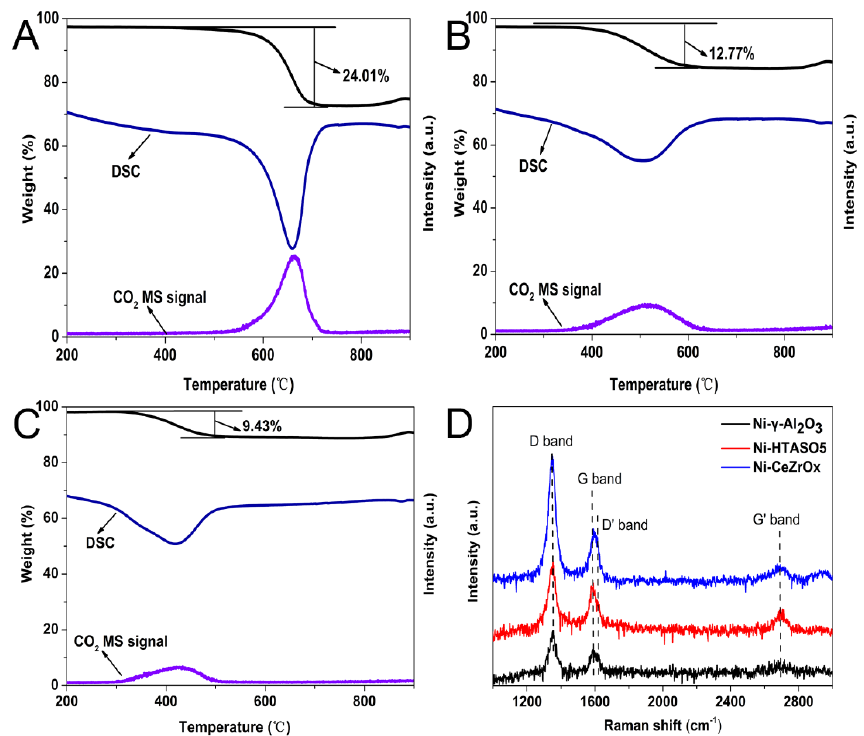
Figure 6. TG ‐ DSC ‐ MS profile. ( A ) Ni ‐γ‐ Al2O3; ( B ) Ni ‐ HTASO5; ( C ) Ni ‐ CeZrO x ; ( D ) Raman spectra of Figure 6. TG-DSC-MS profile. ( A ) Ni- γ -Al2O3; ( B ) Ni-HTASO5; ( C ) Ni-CeZrO x ; ( D ) Raman spectra of different Ni ‐ based catalysts after reaction at 600 °C for nine hours. di ff erent Ni-based catalysts after reaction at 600 ◦ C for nine